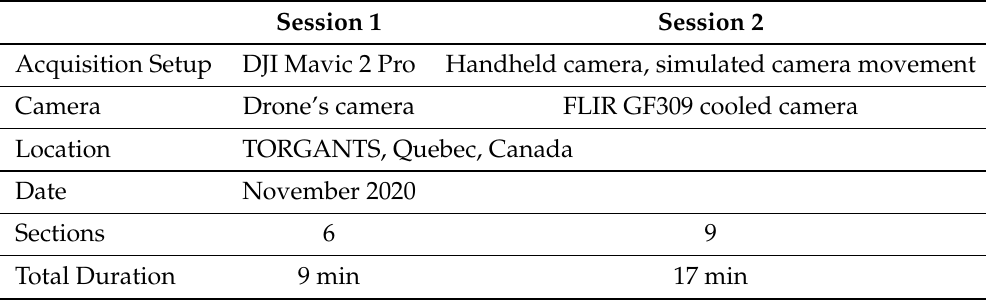
Table 3. The details of Experiment C: the experiment includes two sessions recorded using a drone and a handheld thermal